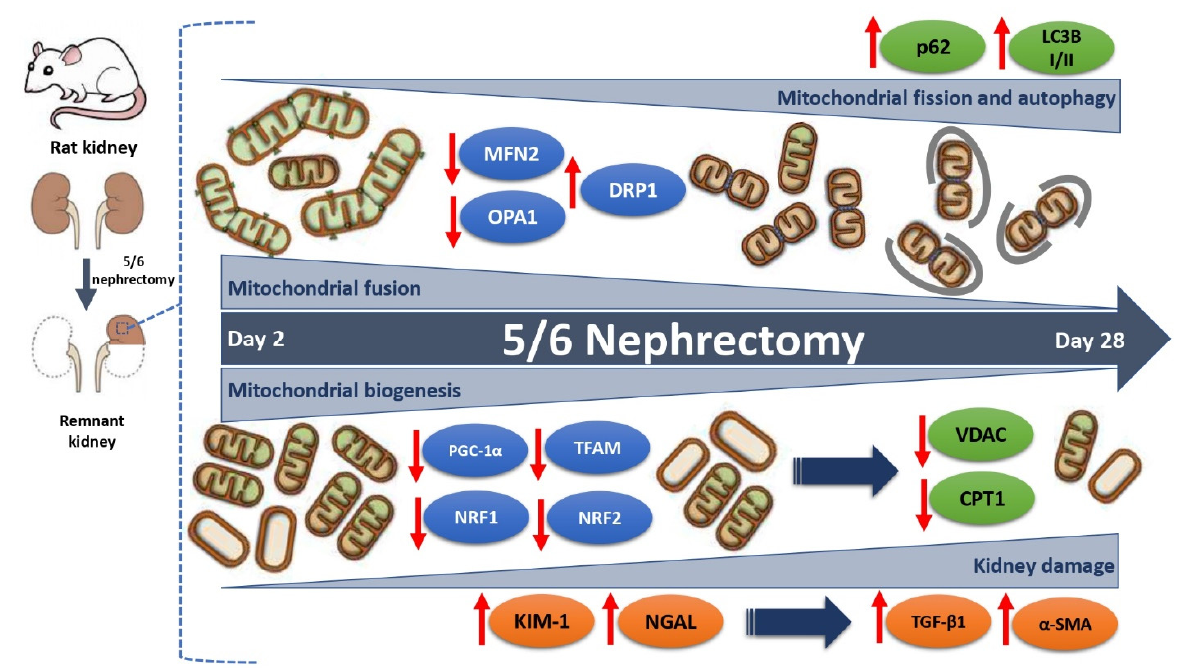
Figure 6. Evolution of mitochondrial biogenesis and dynamics changes in the time interval between day 2 and day 28 after 5/6 nephrectomy (5/6Nx). In this interval, there is a progressive reduction in the levels of peroxisome proliferator-activated receptor gamma coactivator 1-alpha (PGC-1 α ), peroxisome proliferator-activated receptor alpha (PPAR α ), nuclear respiratory factor 1 (NRF1) and 2 (NRF2), and mitochondrial transcription factor A (TFAM), which implies the downregulation of the mitochondrial biogenesis machinery over time. This reduction appears from day 2 and is progressive over time, triggering the decrease in mitochondrial proteins such as voltage-dependent anion channel (VDAC) and carnitine palmitoyltransferase 1 (CPT1) from day 2 to day 28. There is a positive correlation between the reduction in mitochondrial biogenesis factors and the increase in the tubular damage proteins kidney injury molecule-1 (KIM-1) and neutrophil gelatinase-associated lipocalin (NGAL) and the fibrotic markers transforming growth factor beta (TGF- β 1) and alpha smooth muscle actin ( α -SMA). In addition, a slow and gradual change in mitochondrial dynamics from fusion to fission is also shown. This trend started with a reduction on day 2 after 5/6Nx in the fusion proteins mitofusin 2 (MFN2) and optic atrophy 1 (OPA1), favoring the mitochondrial fragmentation observed from 7 days, and continued with an increase in dynamin-1-like protein (DRP1) 28 days after surgery. In addition, macroautophagy markers ubiquitin-binding protein p62 and microtubule-associated proteins 1A/1B light chain 3B I and II (LC3B-I/II) progressively increased with the time, implying the induction of autophagy. This mechanism would principally be present at a chronic stage.